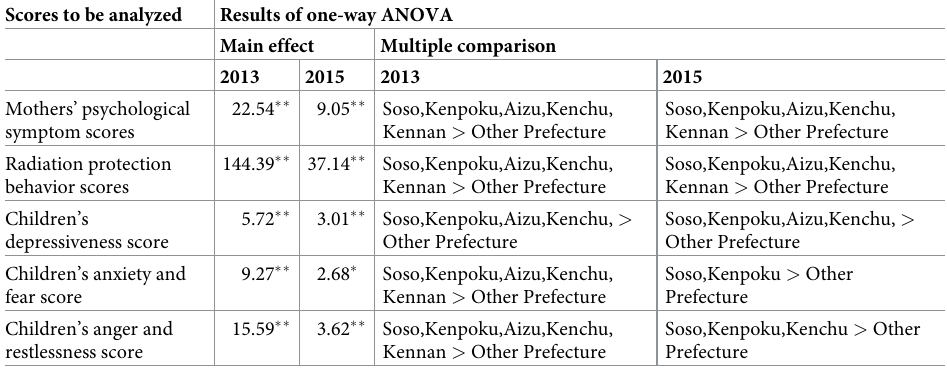
Table 6. Summary of statistical analysis. Scores to be analyzed Results of one-way